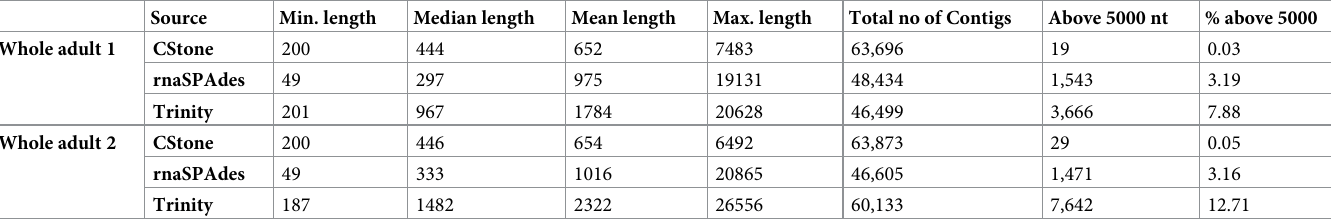
Table 5. Summary of the lengths of assembled contigs relative to the cDNA reference transcripts based on real data.